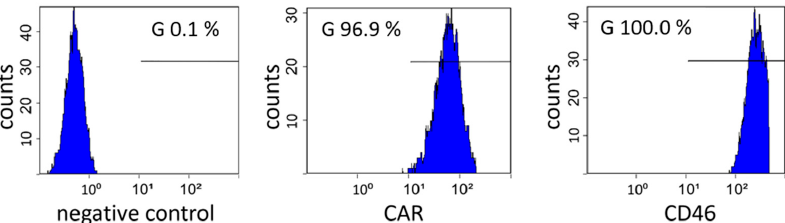
Figure 1. Expression of surface proteins involved in adenoviral cell entry on A549 cells. For CD46, we measured 100% positive cells, and for CAR, 96.4% positive cells. The negative control was analyzed without the use of a primary antibody.